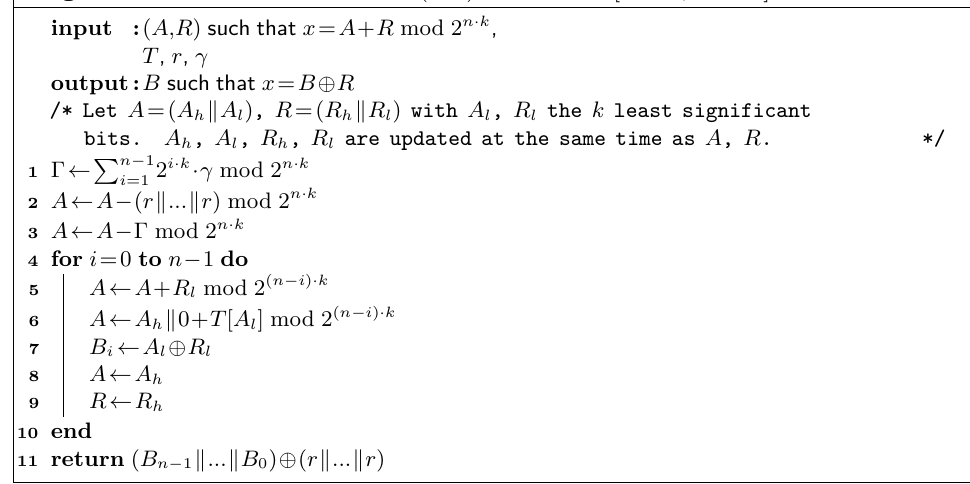
Algorithm 4: A2B conversion of a ( n · k )-bit variable [CT03, Deb12]